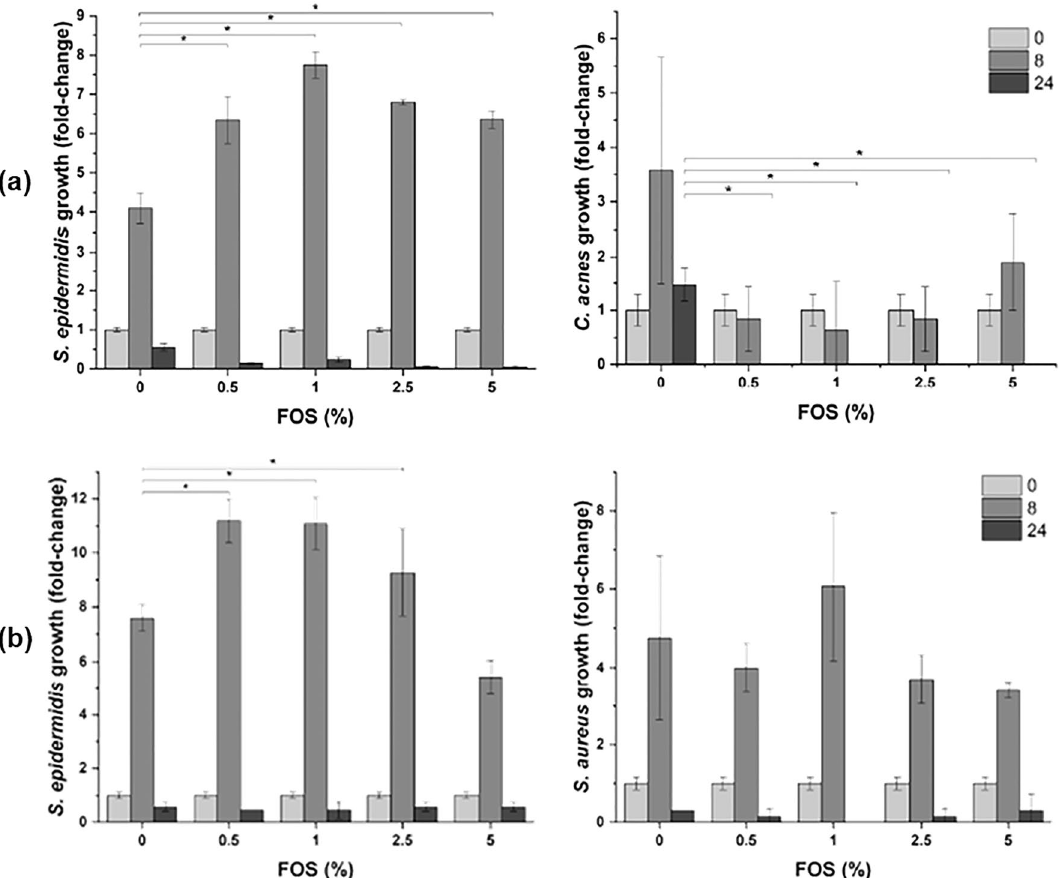
Figure 2. ( a ) S. epidermidis and C. acnes growth during competition and, ( b ) S. epidermidis and S. aureus growth during competition, in minimal medium following exposure to different concentrations of scFOS at 0 (light grey column), 8 (grey column) and 24 h (dark grey column) in aerobic conditions. The results are expressed as fold-change compared to the initially inoculated quantity of each bacterium. The effect of scFOS on the competition between S. epidermidis and C. acnes and S. epidermidis and S. aureus was investigated by inoculating the same amount of the different bacterial strains in minimal medium, in presence of increasing concentration of scFOS (from 0 to 5%). *P < 0.05: significantly different from the value in absence of scFOS (0%) at the same time-point.